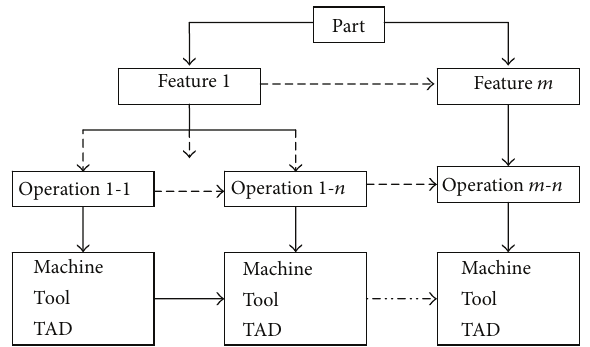
Figure 1: The representation of process plan for a part with 𝑚 feathers.